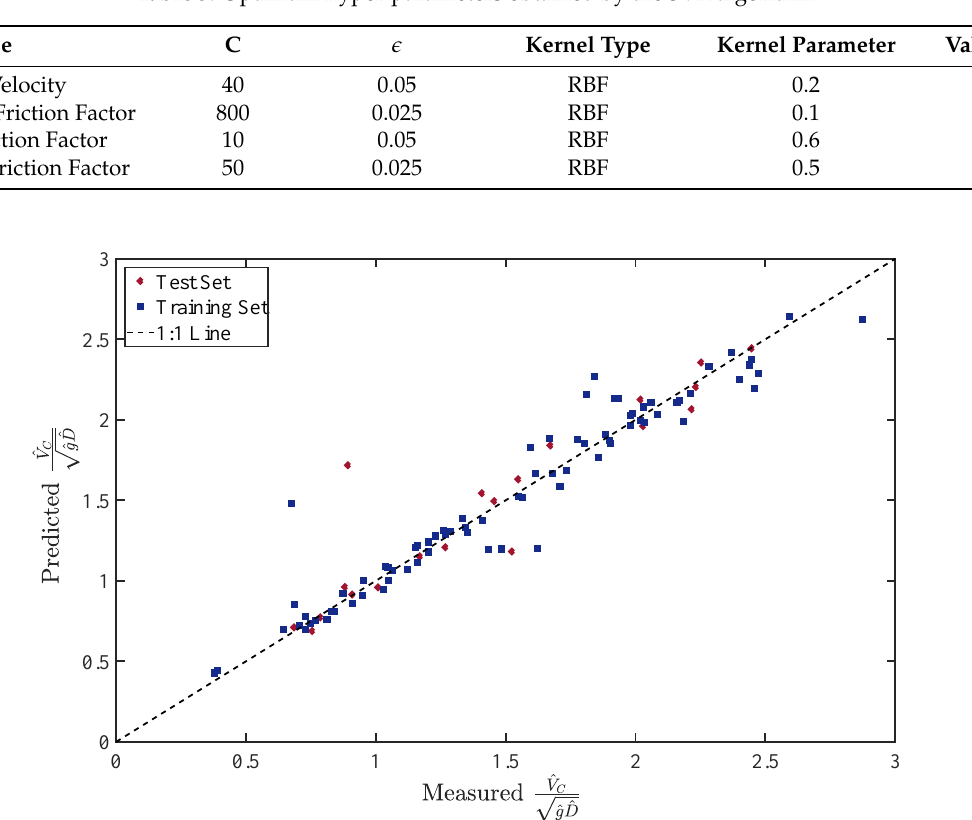
Table 3. Optimum hyper-parameters obtained by the SVR algorithm.